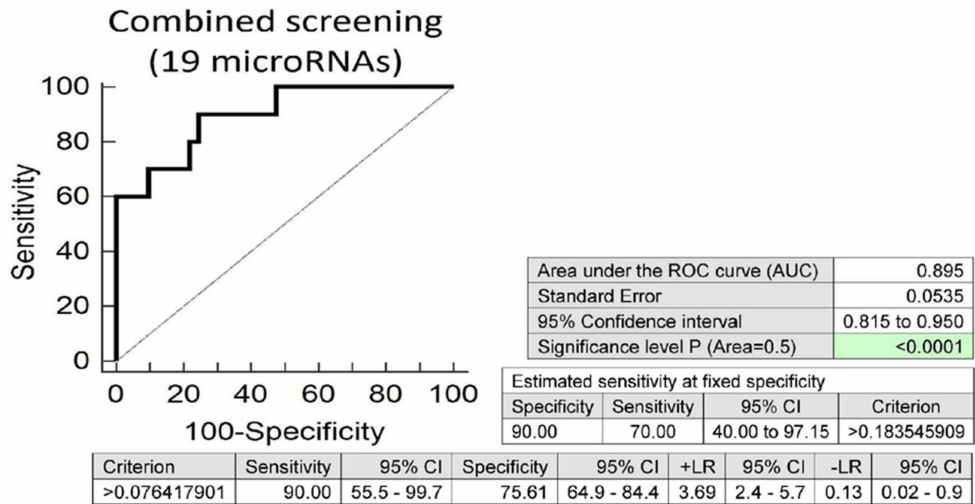
Figure 4. Aberrant microRNA expression profile in overweight / obese children descending from normal pregnancies. Combined screening revealed that at 10.0% FPR, 70.0% of overweight / obese children had a substantially altered microRNA expression profile (miR-16-5p, miR-17-5p, miR-20b-5p, miR-21-5p, miR-23a-3p, miR-24-3p, miR-26a-5p, miR-29a-3p, miR-92a-3p, miR-100-5p, miR-103a-3p, miR-125b-5p, miR-126-3p, miR-130b-3p, miR-145-5p, miR-146a-5p, miR-181a-5p, miR-210-3p and